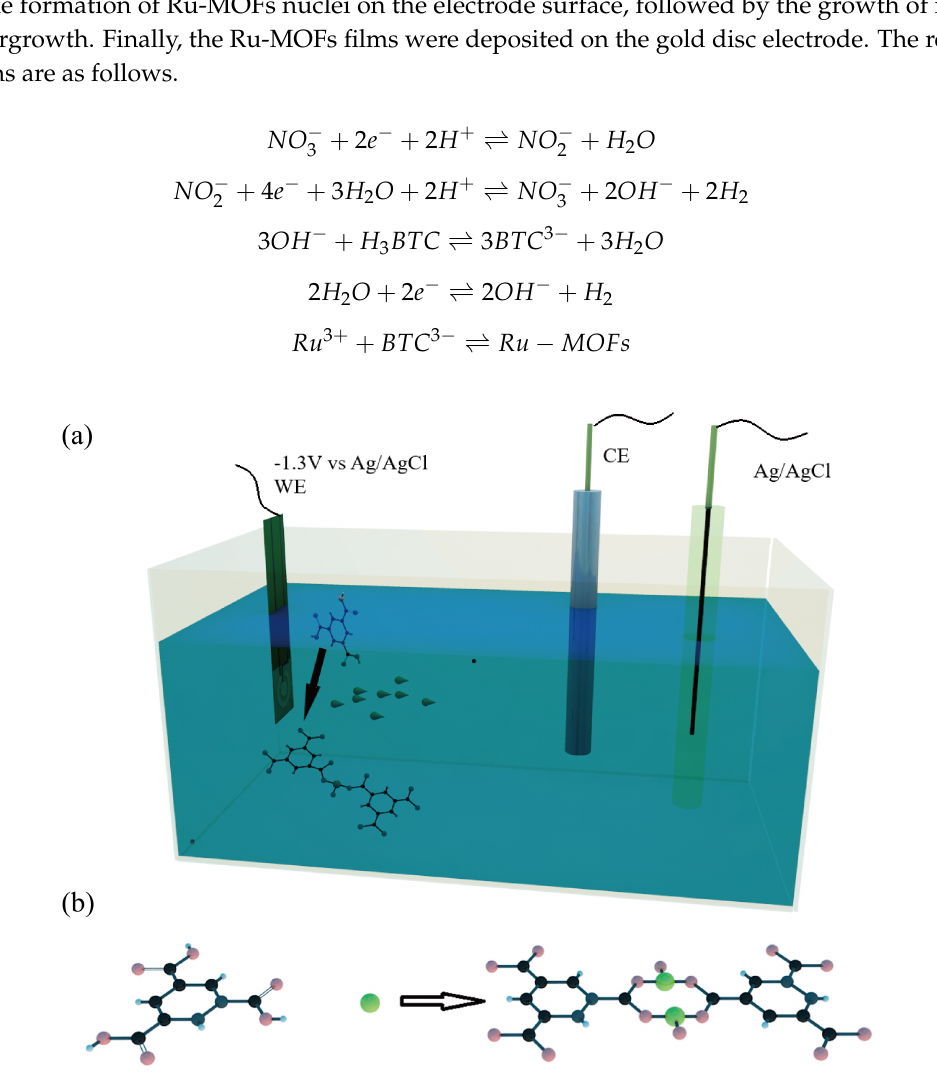
Figure 2. ( a ) Synthesis of Ru-MOFs by electrochemical cathode synthesis. ( b ) representative modulated synthesis